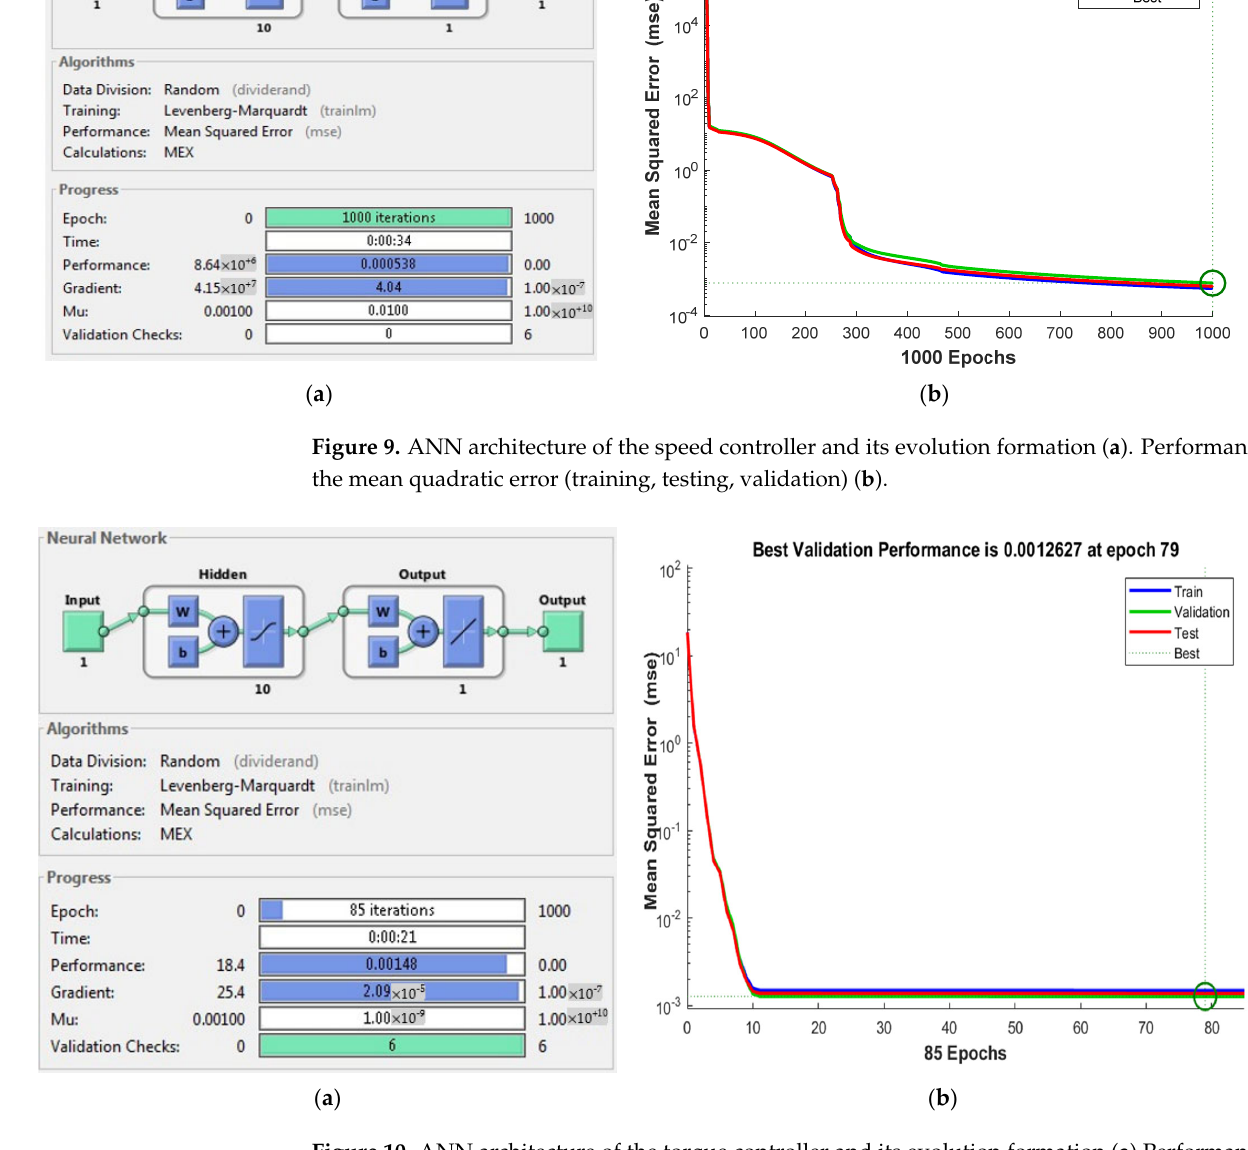
( b ) Figure 11. ANN architecture of the flux controller and its evolution into training ( a ). Performance of the mean quadratic error (training, testing, validation) ( b ).